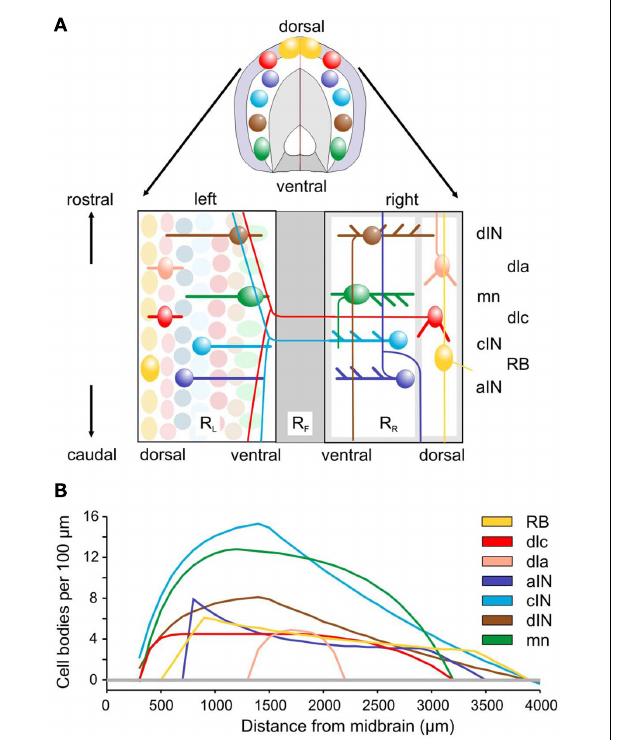
FIGURE 1 | Spinal cord anatomy and experimental measurements. (A) A short length of spinal cord shown in section and after cutting down the dorsal midline and opening flat. Rectangles containing neurons represent the two sides (R L and R R ), separated by the ventral floor plate (dark gray rectangle, R F ). Examples of the cell body positions (ellipses), dendrites (thick lines), and axon projections (thin lines) are illustrated. Neuron types are listed on the right: RB, Rohon Beard sensory neuron; dla, dlc, dorsolateral ascending and dorsolateral commissural sensory interneurons; dIN, cIN, aIN, descending, commissural, and ascending premotor interneurons; mn, motoneurons. (B) Longitudinal distributions of neuron cell body numbers (per 100 μ m).The curves show smoothed, theoretical distributions based on current anatomical estimates and updated from Li et al. (2001).The color coding indicated for each cell type is used throughout this